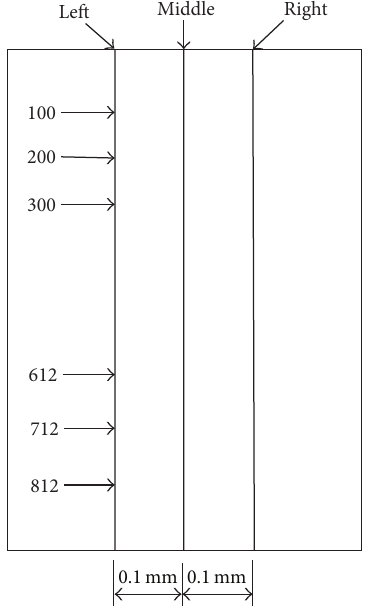
Figure 7: Schematic diagram of extracted three lines and three sections of every